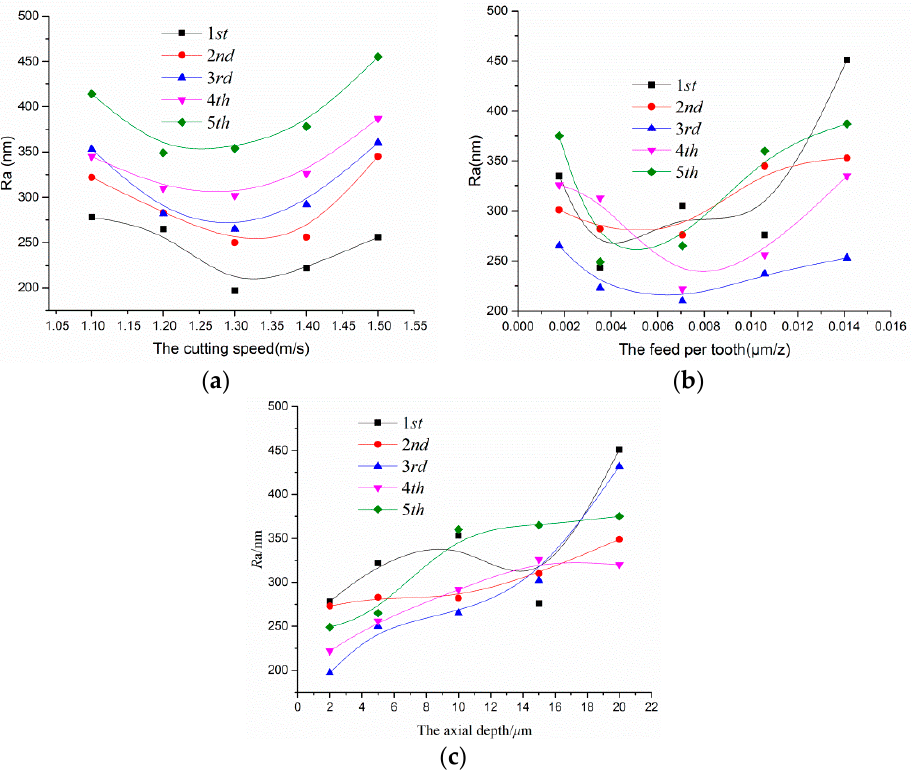
Figure 11. Effects of processing parameters on R a for Ti6Al4V. ( a ) Change in R a with the cutting speed. ( b ) Change in R a with the feed per tooth. ( c ) Change in R a with the axial cutting depth